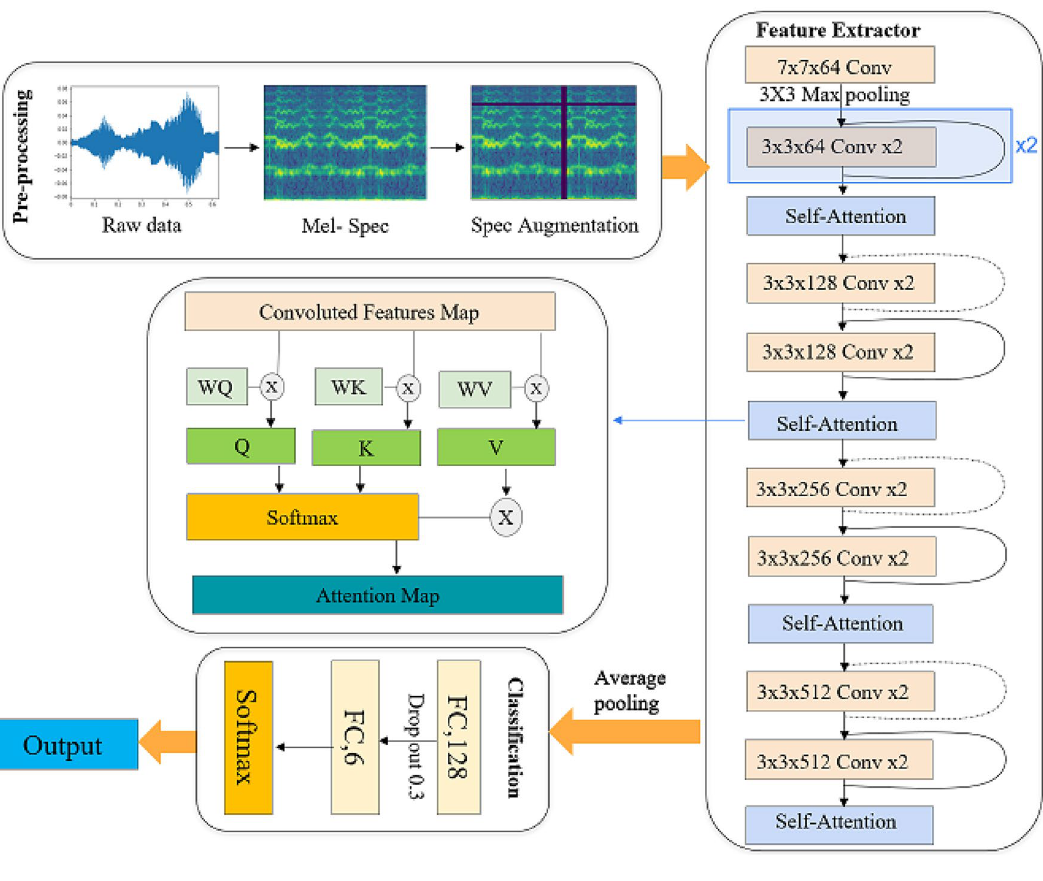
Figure 4. The architecture of our WbNet